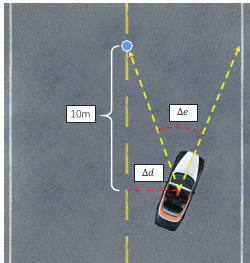
Figure 4. Schematic diagram of generating labels from the vehicle-road relationship. Algorithm 1: Progressive optimization algorithm of the DNN reward model under the human-machine